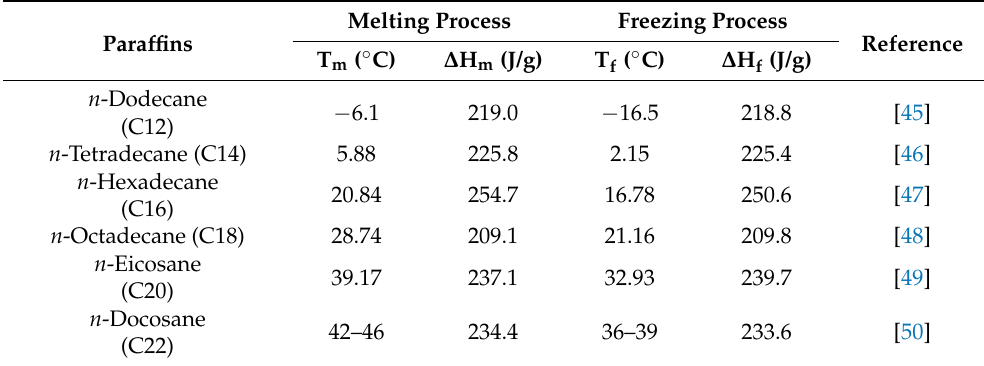
Table 2. Phase change properties of common